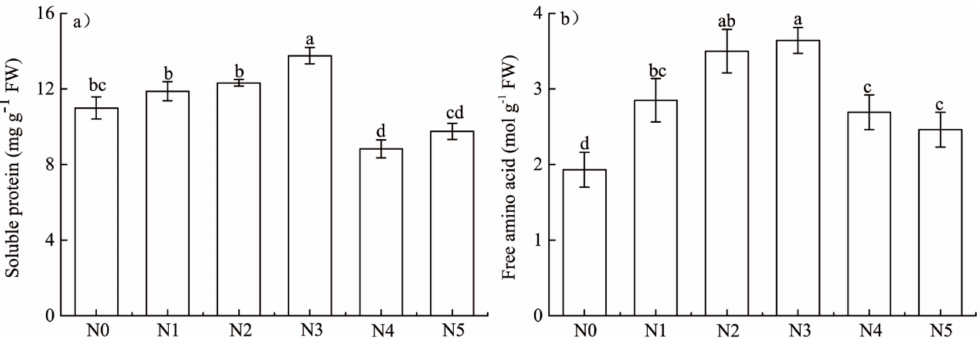
Figure 2. Effects of N treatments on the content of soluble protein ( a ) and free amino acid ( b ) in leaves of Cupressus lusitanica Mill. Notes: Values shown are the mean ± S.E. ( n = 3); Different letters indicate significant differences at p < 0.05 among the different N treatments.